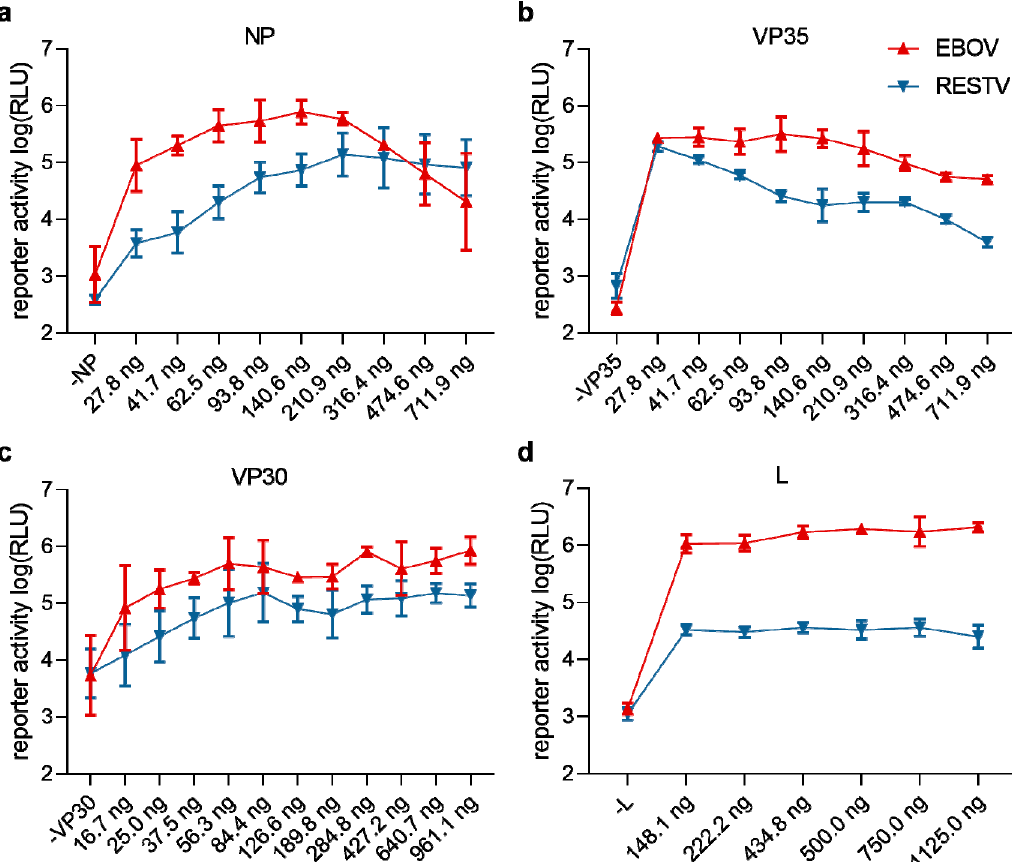
Figure 4. Optimization of RESTV and EBOV RNP expression plasmid concentrations. Reporter activity, reflecting viral RNA synthesis, in 293T cells transfected with an EBOV monocistronic minigenome plasmid and expression plasmids for RNP proteins for either RESTV (blue) or EBOV (red) is shown. Plasmid amounts for NP ( a ), VP35 ( b ), VP30 ( c ), or L ( d ) were titrated, as indicated. As a negative control, each of the respective plasmids was replaced by an empty vector. Means and standard deviations of 3 independent experiments are shown.